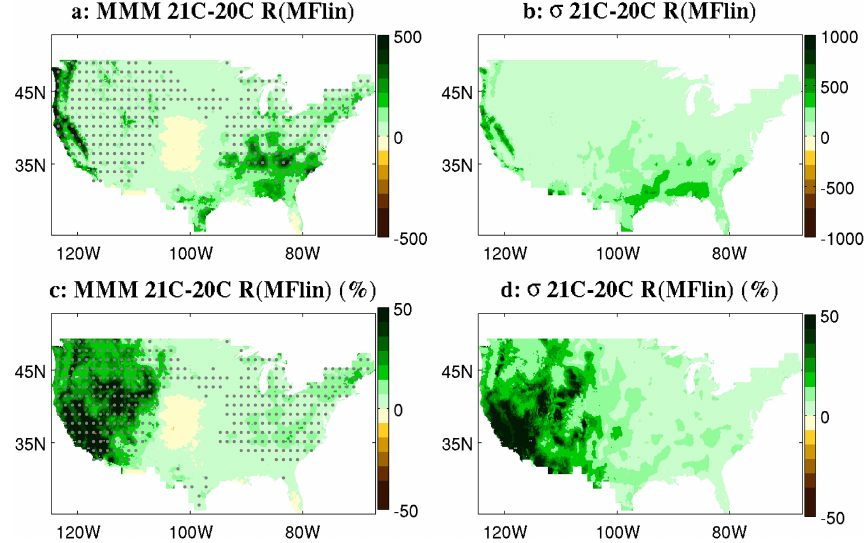
Figure 13. As in Fig. 12, but for erosivity calculated by non-linear regression from the modified Fournier index F (method 2).